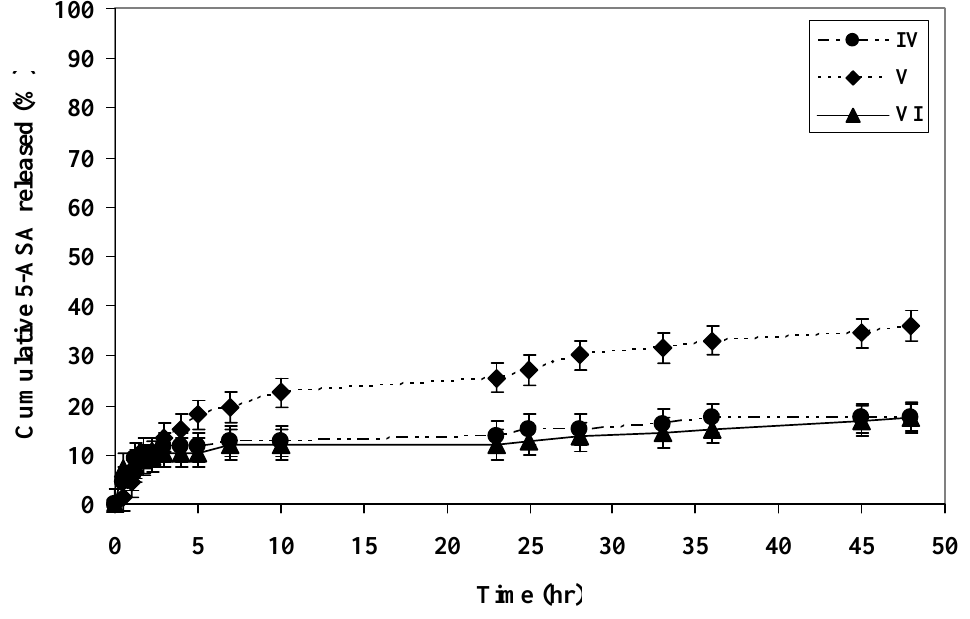
Figure 5. In vitro 5-ASA release from polymers IV – VI in phosphate buffer solution (pH 1.5) at 37